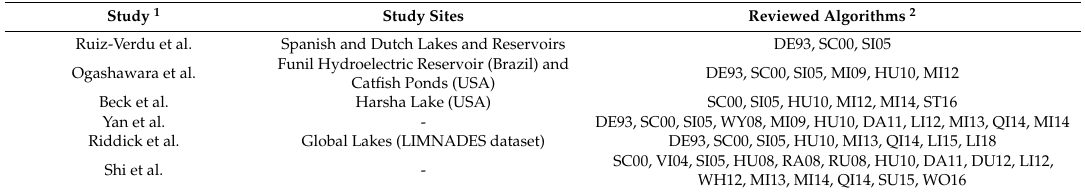
Table 1. Summary of paper reviews on remotely estimation of